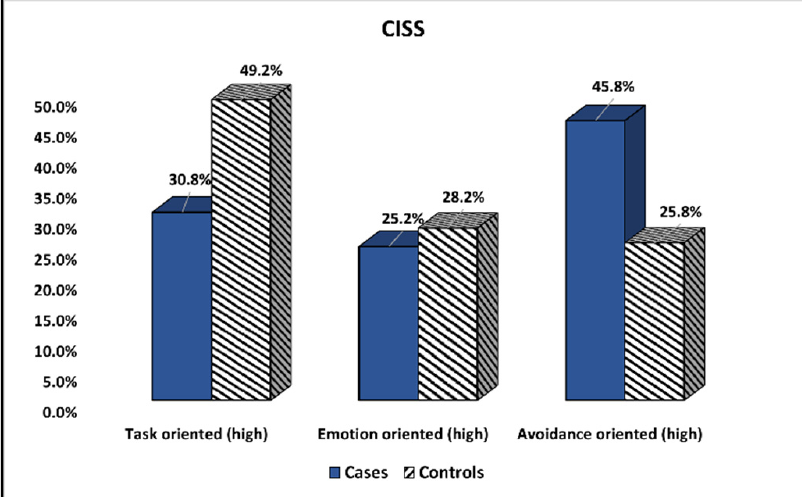
Figure 1. Comparison of CISS survey results between cases and controls.